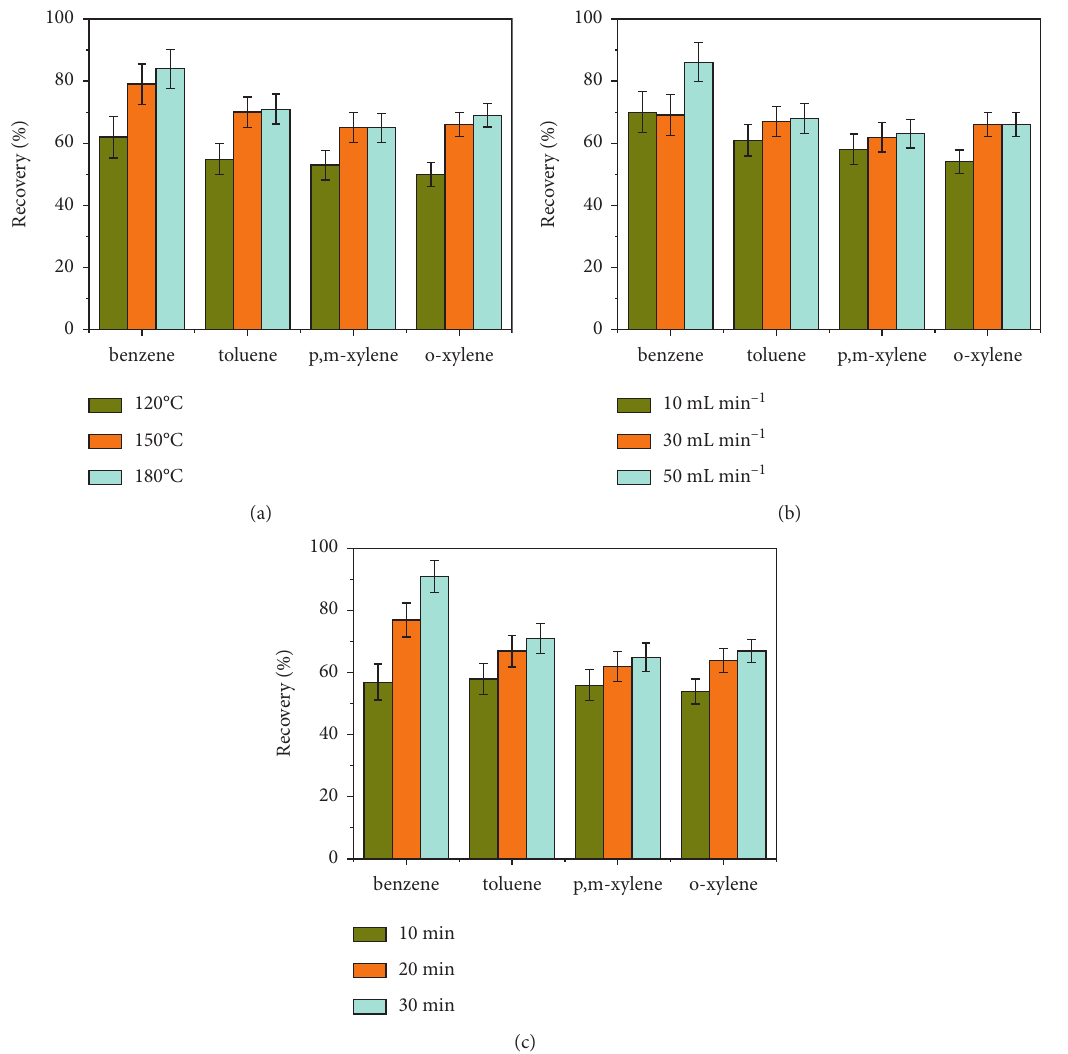
Figure 3: Effect of (a) desorption temperature, (b) desorption flow rate, and (c) desorption time, on desorption efficiency of